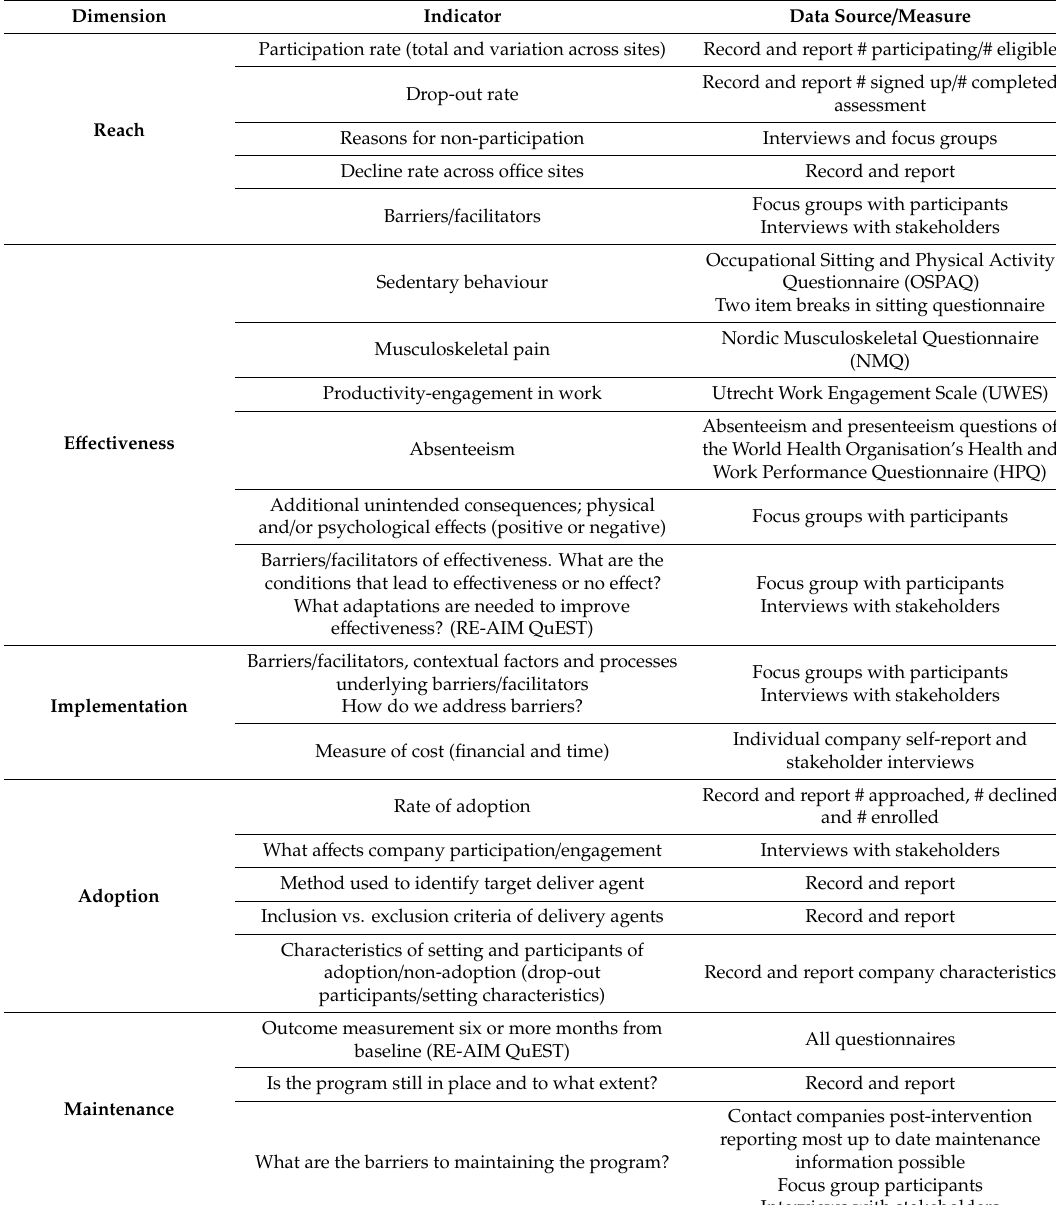
Table 1. RE-AIM dimensions, indicators assessed and the data source used to measure or inform indicators.